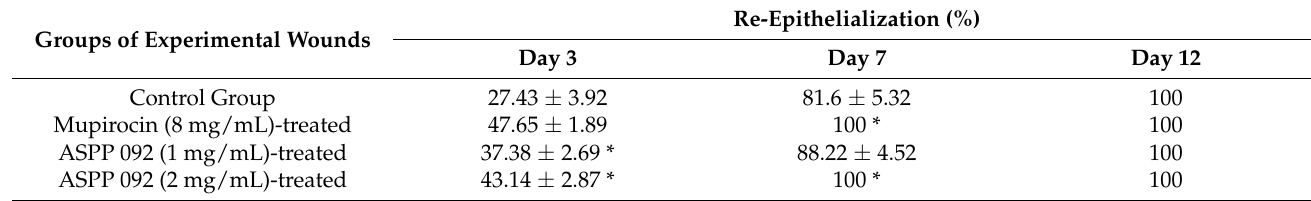
Table 1. Re-epithelialization in the experimental wounds at different time intervals. The experimen- tally induced wounds were treated with either mupirocin or ASPP 092 at concentrations of 1 mg/mL and 2 mg/mL. A vehicle control group was also maintained. Re-epithelialization in the wounds was calculated and expressed as percentage changes. The analyzed data are represented as mean ± SEM. * p < 0.05 was considered to be statistically